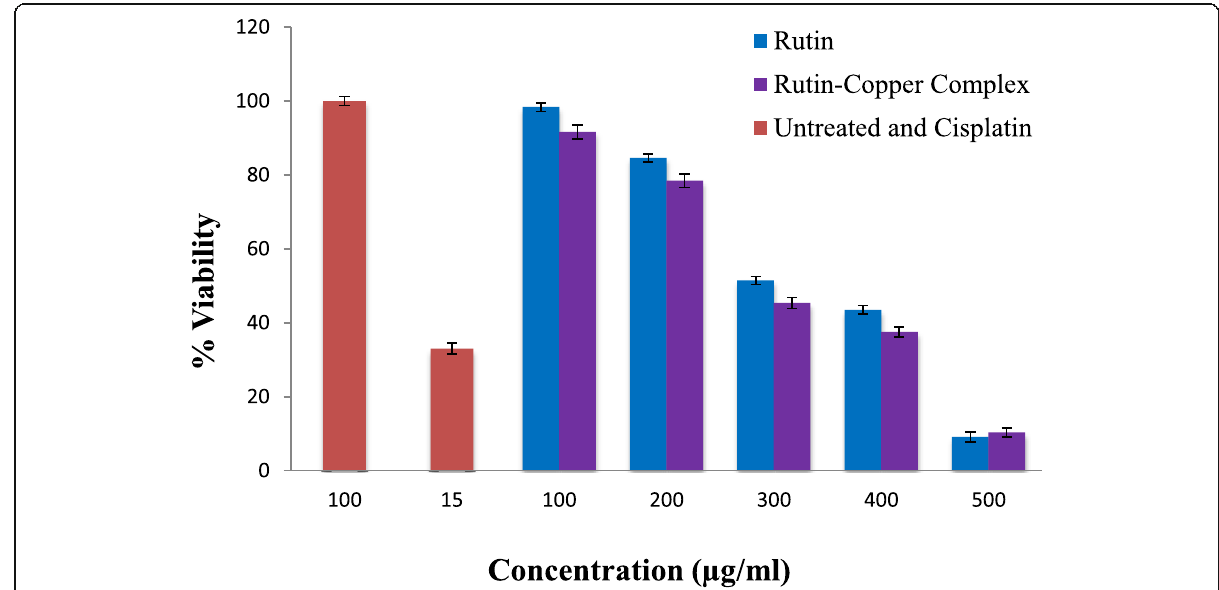
Fig. 2 Effect of rutin and rutin-copper complex on MDA MB-468